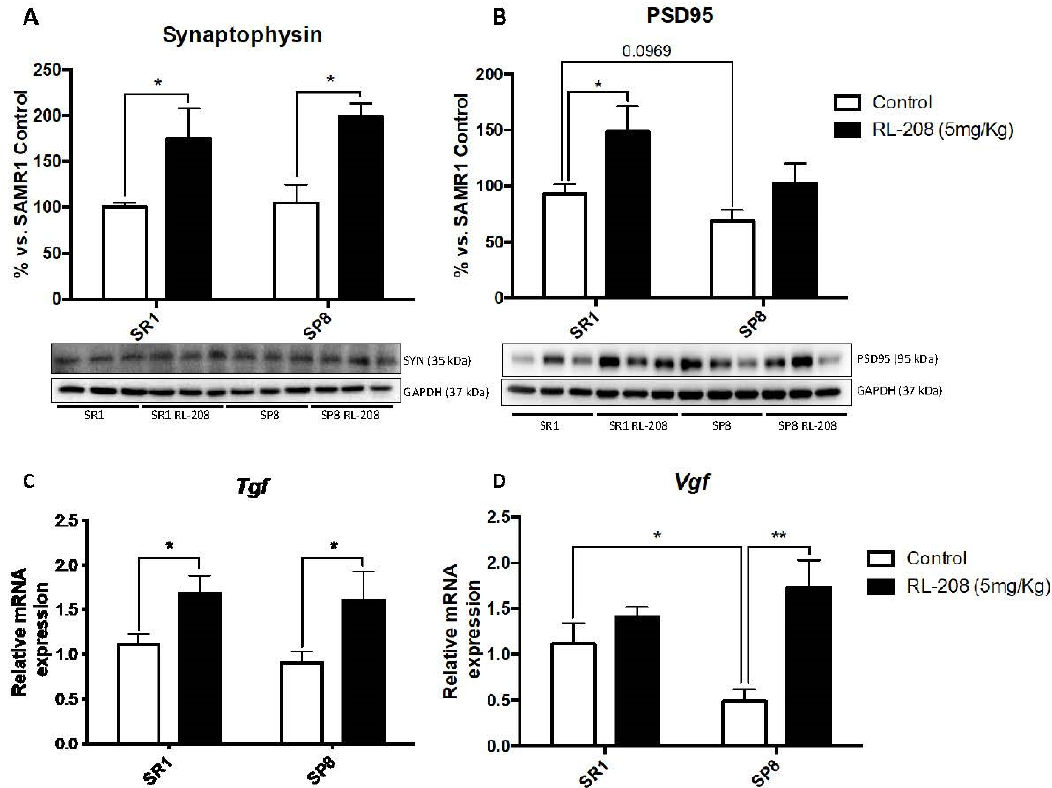
Figure 5. Representative Western Blot and quantifications for Synaptophysin ( A ), and PSD95 ( B ). Representative gene expression for Tgf ( C ), and Vgf ( D ). Values in bar graphs are adjusted to 100% for protein levels of the control SAMR1 (SR1 Ct). Gene expression levels were determined by real-time PCR. Values are the mean ± Standard error of the mean (SEM); (n = 6 for each group). * p < 0.05; ** p <